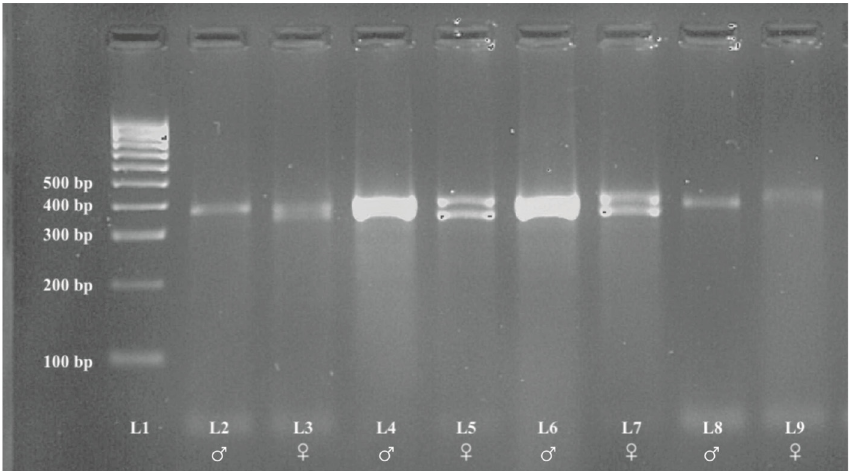
Figure 3. PCR results from feather samples. Legend: L1—Size standard (100-bp DNA ladder), ♂ —male, ♀ —female, L2 and L3 Domestic Pigeons ( Columba livia domestica ), L4 and L5 Scarlet-chested Parrots (Neophema splendida ), L6 and L7 Rose-ringed Parakeets ( Psittacula krameri ), L8 and L9 Lovebirds ( Agapornis spp.).